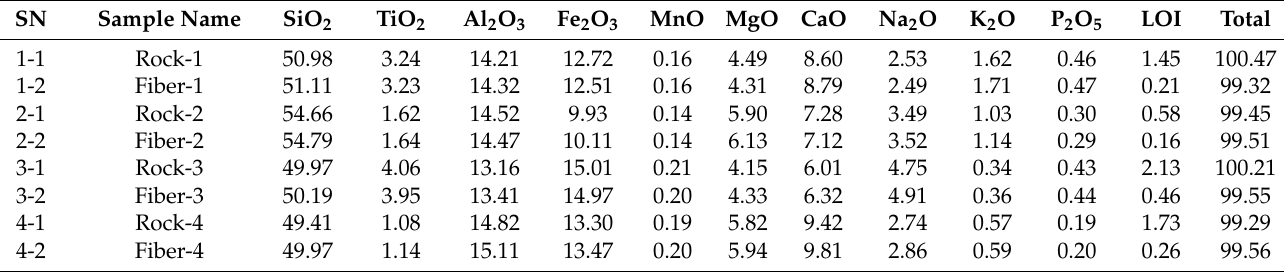
Table 1. The results of XRF of basalt and corresponding fiber